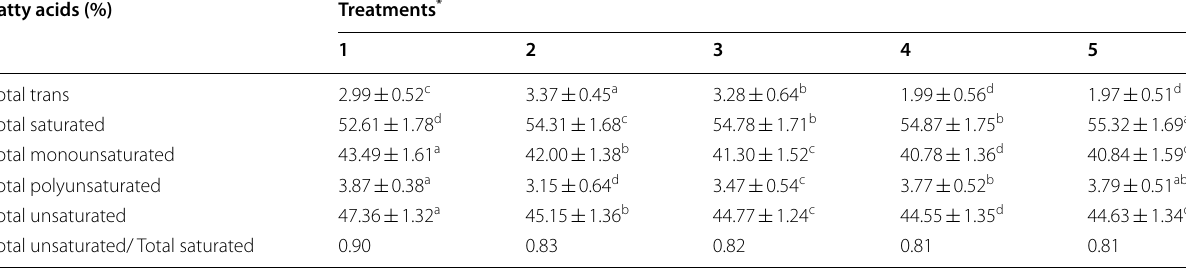
Values are means standard error of three replicates a (1): Raw control sample, (2): 2% cowpea flour was added raw sample, (3): 4% cowpea flour was added raw ± sample, (4): 6% cowpea flour was added raw sample, (5): 8% cowpea flour was added raw sample. Means within the same row with diffeerent superscripts are significantly different ( P < 0.05)